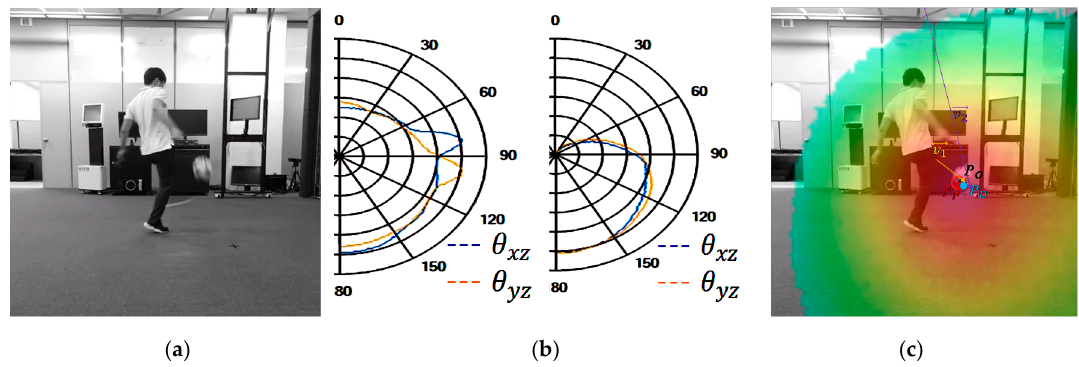
Figure 11. Results of the 3D acoustic source localization method: ( a ) Generation of impulsive acoustic source by kicking a ball, ( b ) the results of DSBF direction on the top plane (left) and on the side plane (right), and ( c ) the results of the conventional spherical model-based method and the proposed dual planar model-based method.